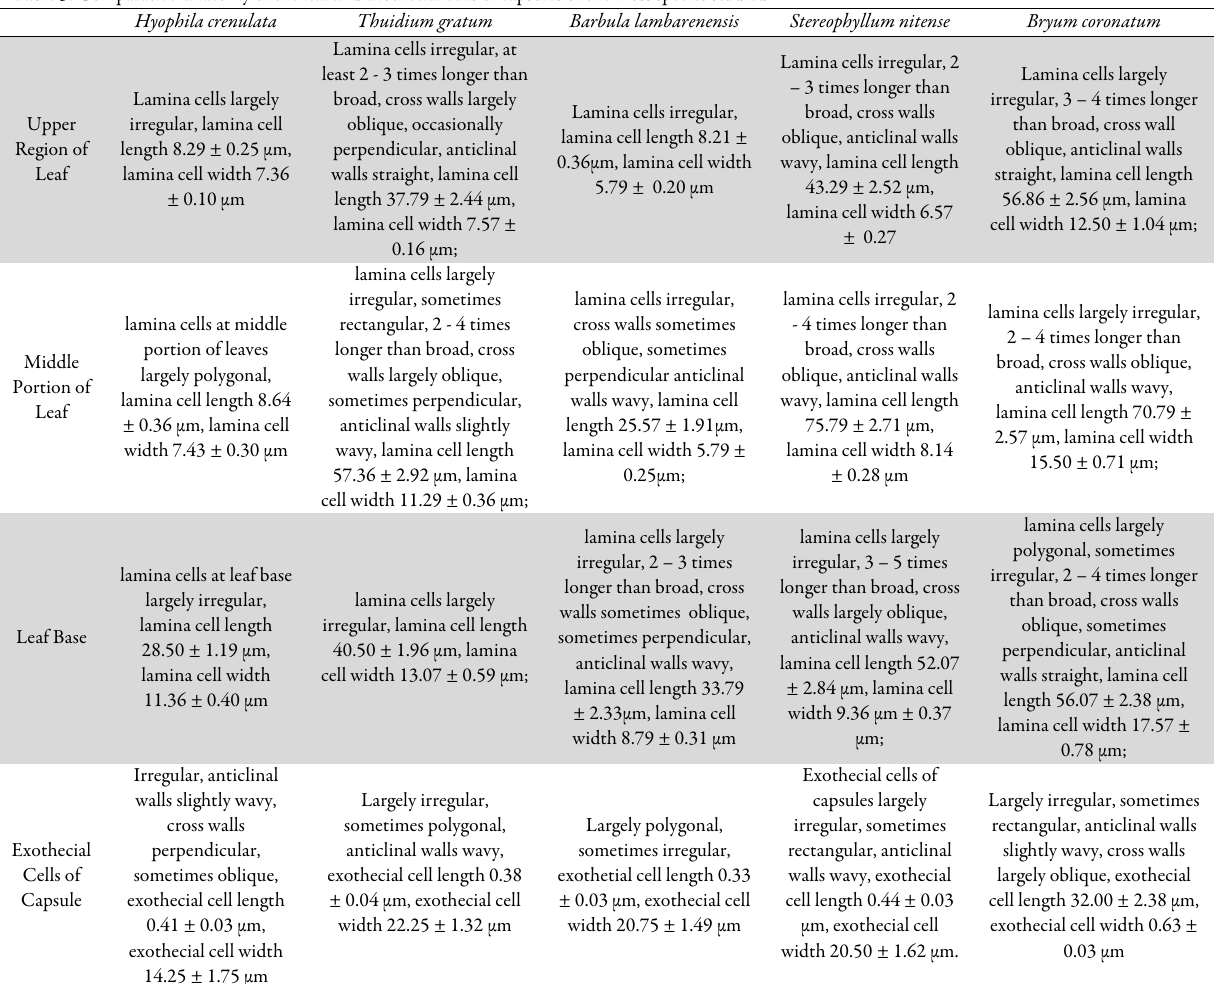
Table 3. Comparative anatomy of the leaf and exothecial cells of capsules of the moss species studied Hyophila crenulata Thuidium gratum Barbula